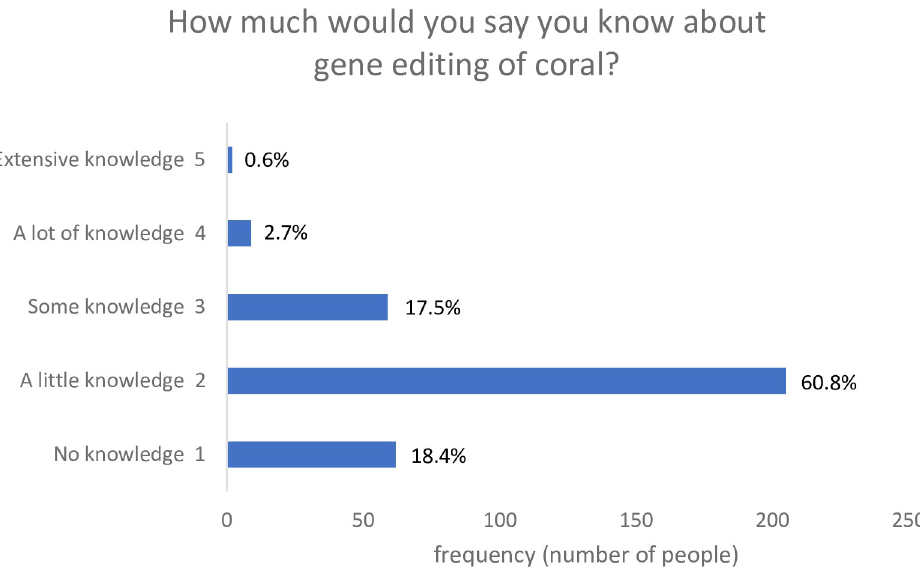
Fig 1. Knowledge of gene editing of coral (N =